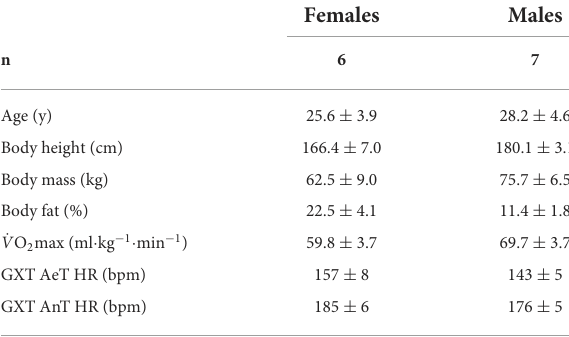
TABLE 1 Anthropometric and performance characteristics. Females